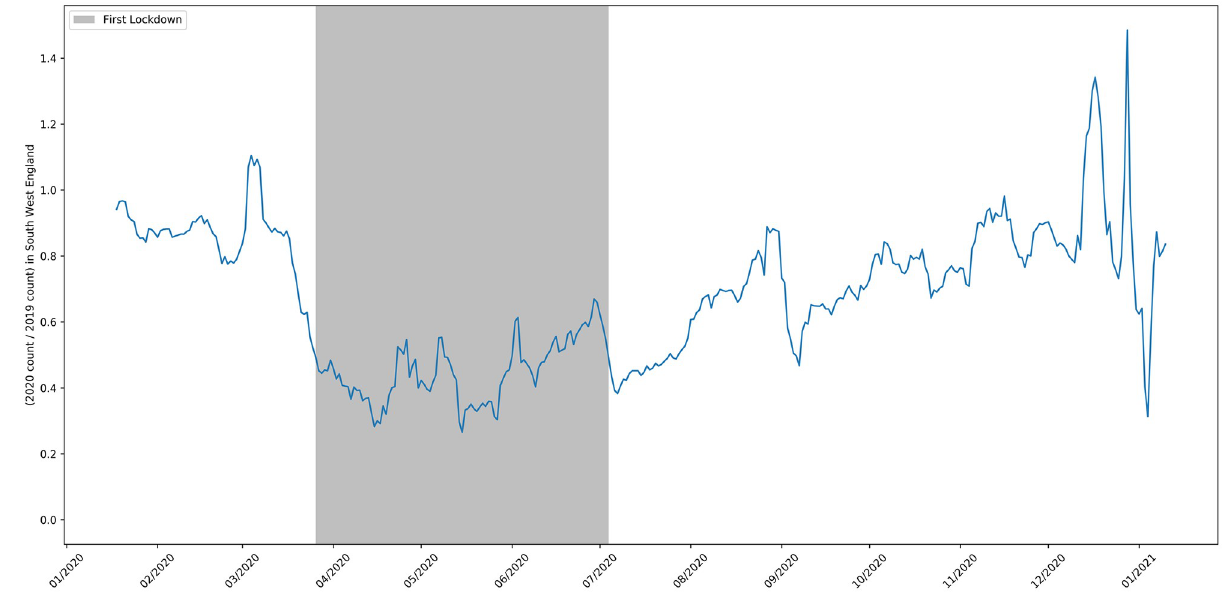
Fig 14. The ratio of job adverts in the North East.